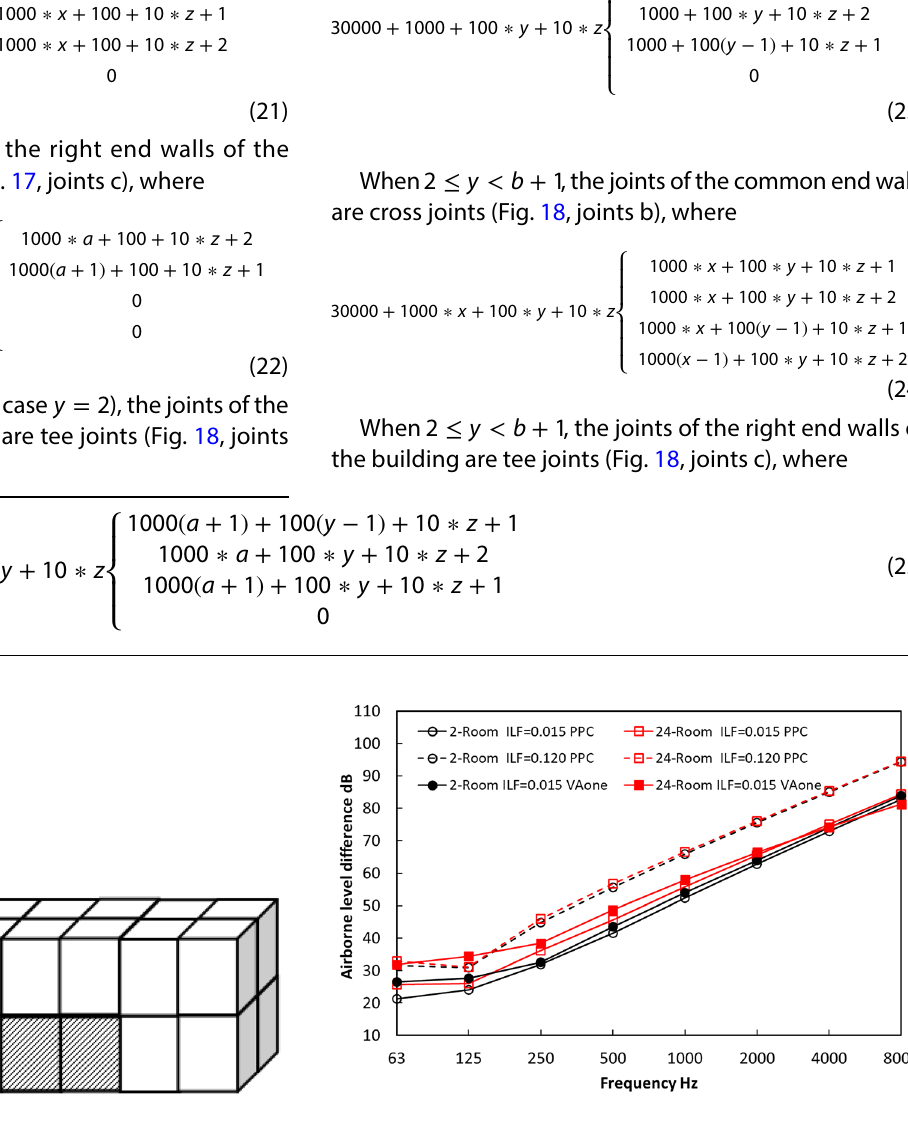
Fig. 21 Air-borne energy level differences between the source room and the receiving room for simple and complicated system predicted by VAone and